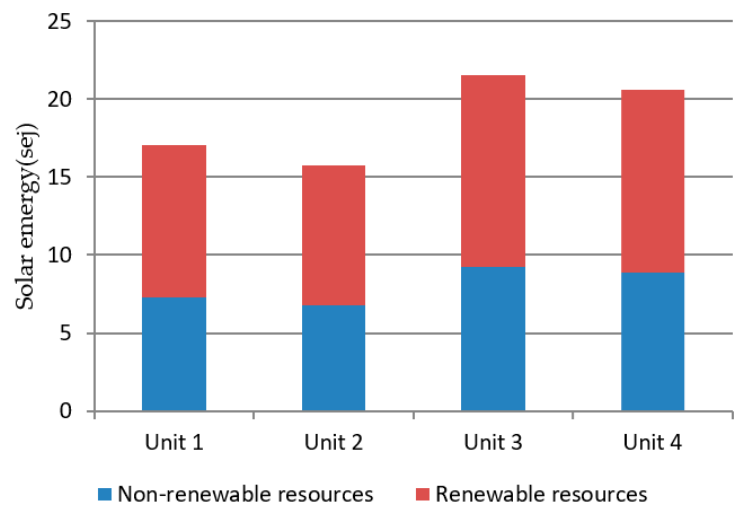
Figure 2. Comparisons of renewable and non-renewable resource consumption ( × 10 24 ).